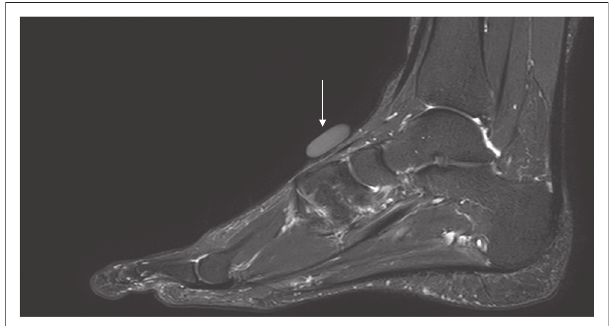
FIGURE 1: Sagittal T2 FS MR image demonstrating a vitamin E capsule (arrow) used to indicate the region of discomfort.